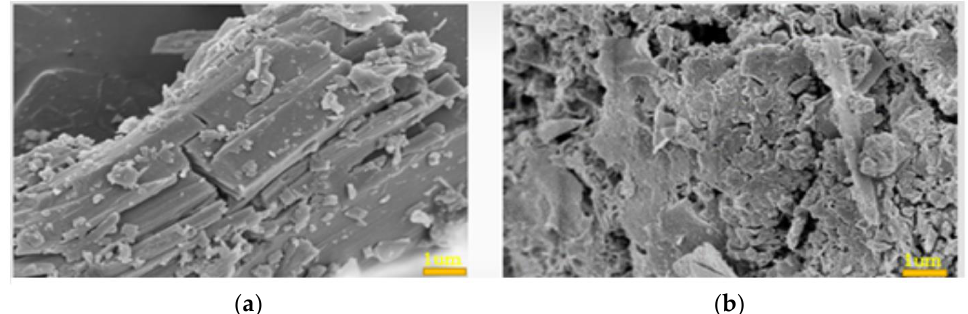
Figure 12. SEM images of flame-retardant coatings ( a ) before, and ( b ) after heating to 1000 °C for an hour. (magnesia/KH 2 PO 4 molar ratios = 4; wollastonite:vermiculite = 20:10 wt.%; aluminum trihydroxide = 10 wt.%; calcium carbonate = 5 wt.%).